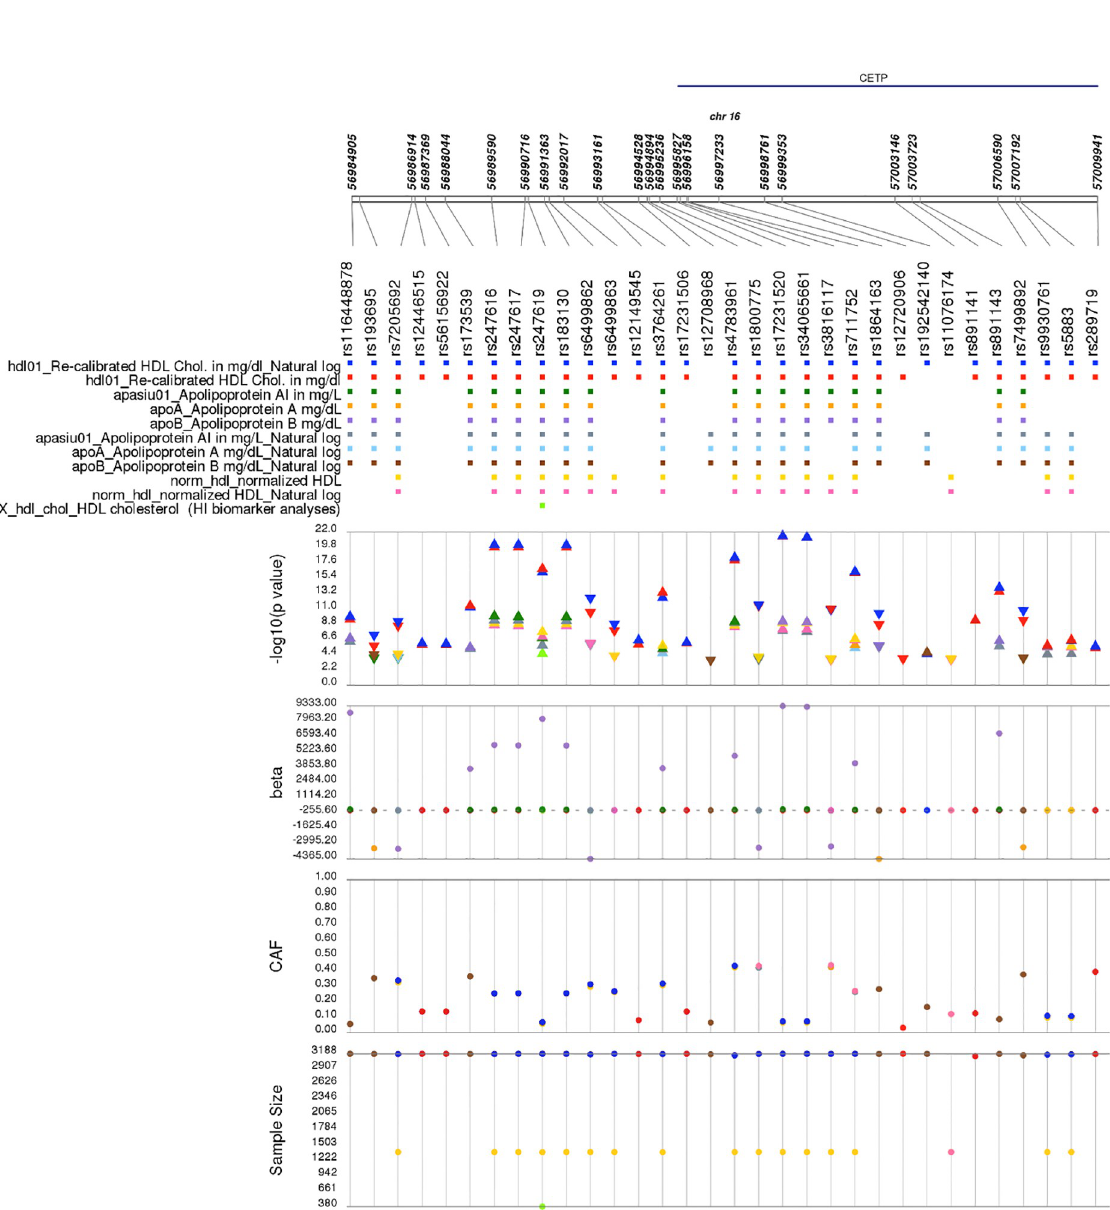
Fig 5. CETP rs3764261 and nearby single nucleotide polymorphisms associated with lipid-related traits in a single Population Architecture using Genomics and Epidemiology (PAGE) study. Plotted are single SNP tests of association in the Atherosclerosis Risk in Communities (ARIC) for CETP rs3764261 and nearby SNPs within 100kb of previously-reported genome-wide association study (GWAS) associations also associated here at p < 1.0x10 -4 with lipid-related traits. Data shown are sample size, coded allele frequency (CAF), genetic effect size (beta), -log10(p-value), and ARIC phenotypes on the y-axes. Each SNP is plotted on the x-axis at the top of the figure from 5´ to 3 0 , and genomic positions along chromosome 16 along with annotated genes are given above. Data are color-coded by phenotype and displayed as a square (for SNPs), a triangle (p-values), or closed circles (betas, CAFs, and sample size). Direction of the triangle represents the direction of the effect